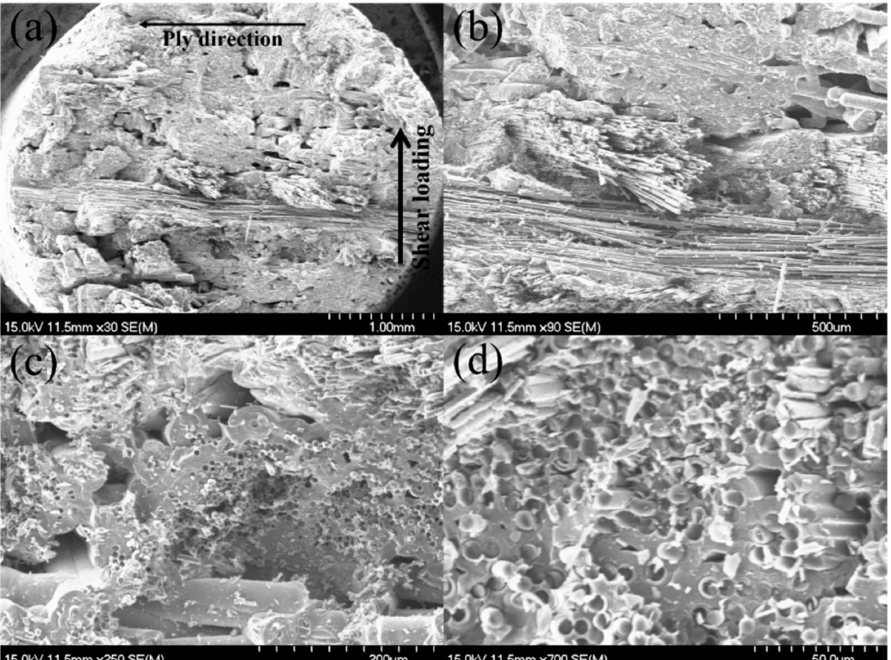
Figure 8. Type I double-shear fracture surface of the 12k T-700 TM MWK–N–C/SiC pin observed under SEM. ( a ) fracture surface; ( b ) fiber pullout in different plies; ( c ) fiber pullout; ( d ) fiber fracture and pullout.